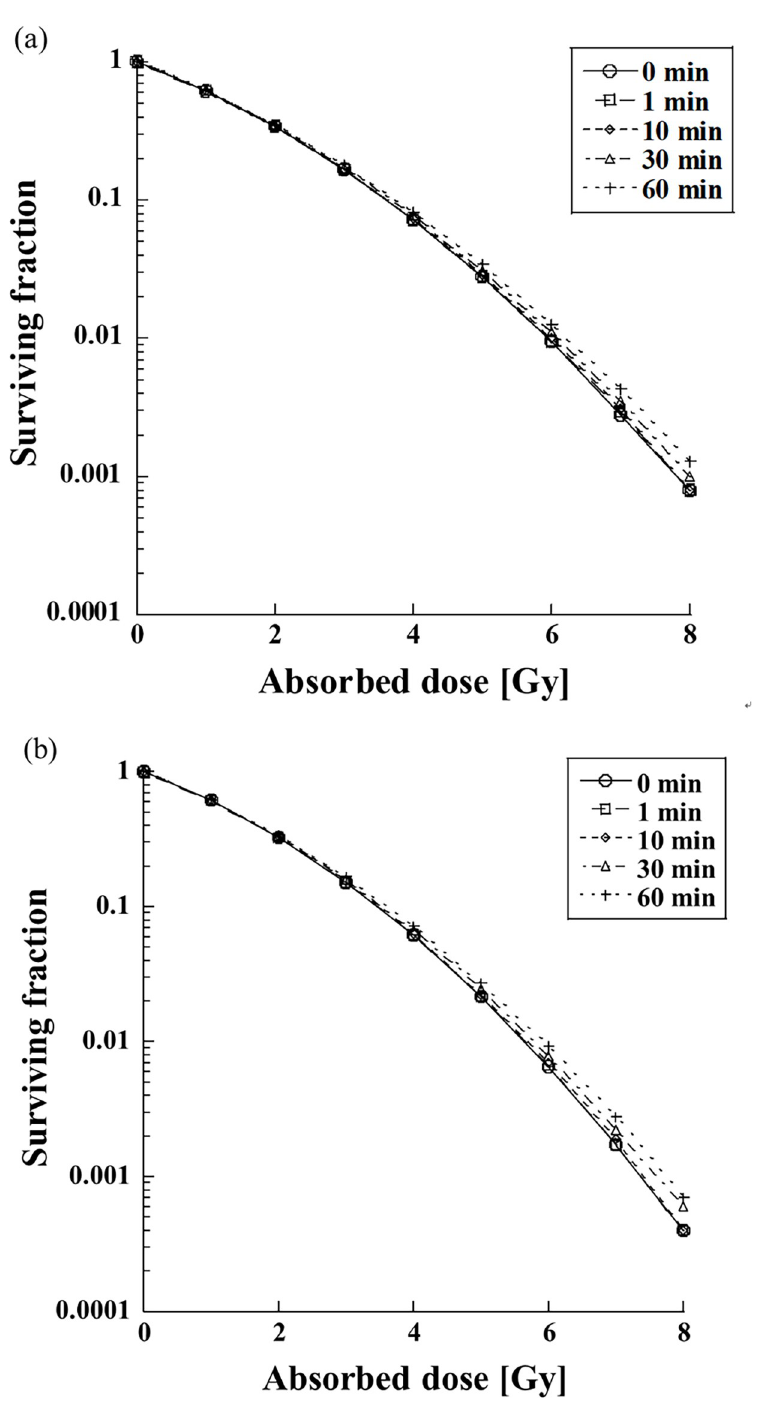
Fig 4. Effect of the dose-delivery time on the SF for FF (upper plots) and FFF (lower plots) beams for various dose-delivery times. RBEs of FF and FFF beams were found, and both RBEs decreased with increased dose-delivery time. Both RBEs were affected when the dose-delivery time was 30 min or larger, where they